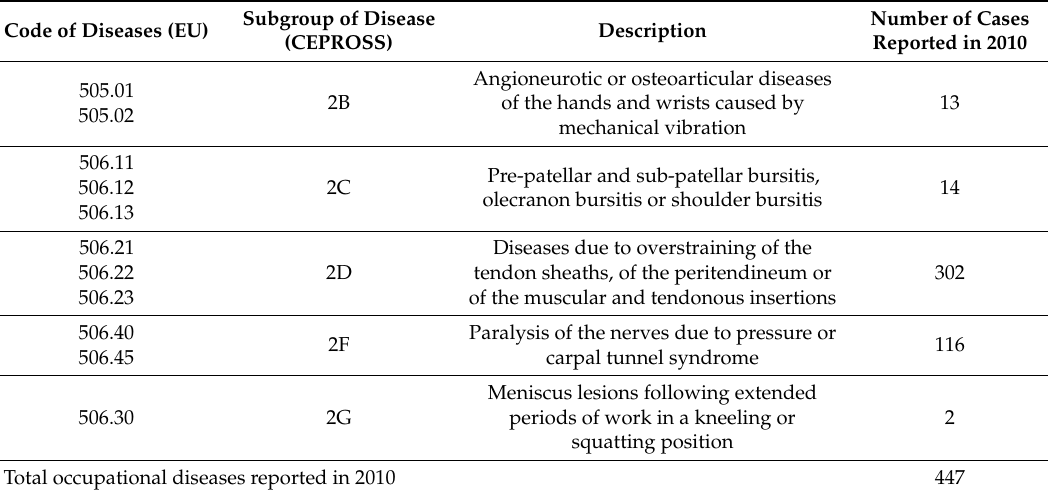
Table 1. Musculoskeletal diseases reported in Andalusia in 2010.